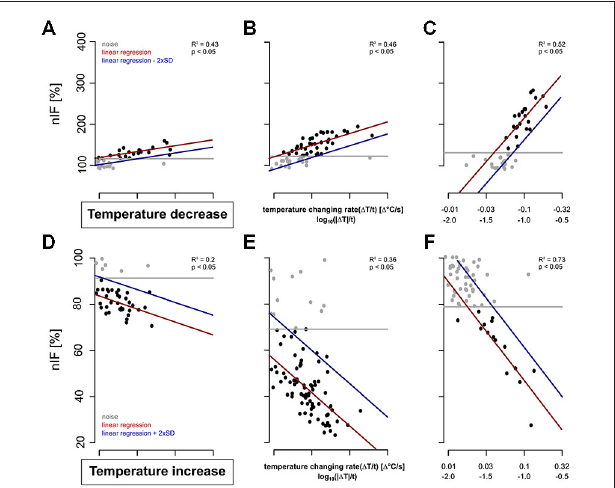
FIGURE 5 | Examples of dose-response curves (red) of six TT-neurons. The neuronal activities of the cold-sensitive neurons 240 s after stimulus onset are represented in gray and black. The noise level of the resting activity is indicated by the gray line and that of the neuronal response during temperature stimulation in blue. (A–C) : Three TT-neurons stimulated with cold air stimulus with (A) low differential sensitivity and low detection threshold, (B) intermediate differential sensitivity and low detection threshold, and (C) high differential sensitivity and high detection threshold. (D–F) : Three TT-neurons stimulated with increasing temperature with (D) low differential sensitivity and low detection, (E) intermediate differential sensitivity and low detection threshold, and (F) high differential sensitivity and high detection